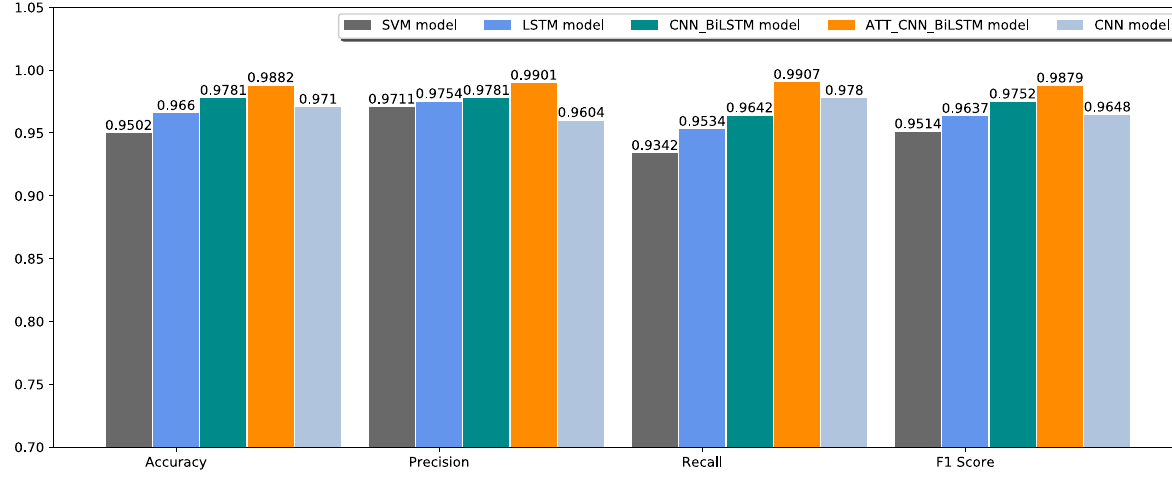
Fig. 3 Evaluation results on the detection of DGA domain